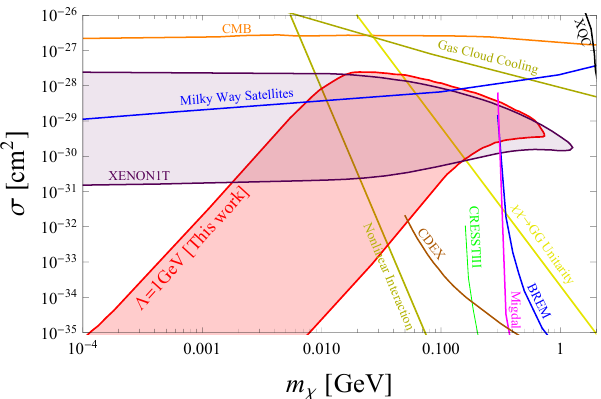
Figure 4 . Constraints on the spin-independent CRDM cross section from the XENON-1T exper- iment. We assume the cut-off scale Λ = 1GeV . The pink color region is the result of this work. The light blue region is the result assuming the constant cross section [23]. For comparison, the exclusion curves from the CMB observations [45], the gas cloud cooling [46], the X-ray Quantum Calorimeter experiment (XQC) [47], other direct detection experiments [48] and CDEX [11] are also